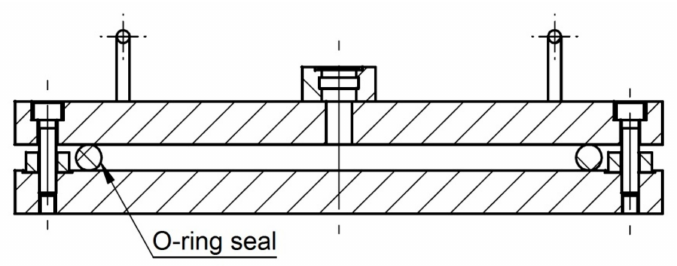
Figure 1. O-ring in fixture for leakage rate measurements before compression by